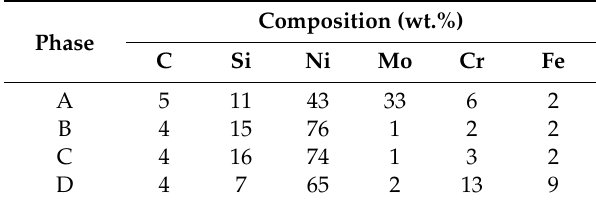
Table 1. Chemical composition of di ff erent phases in the